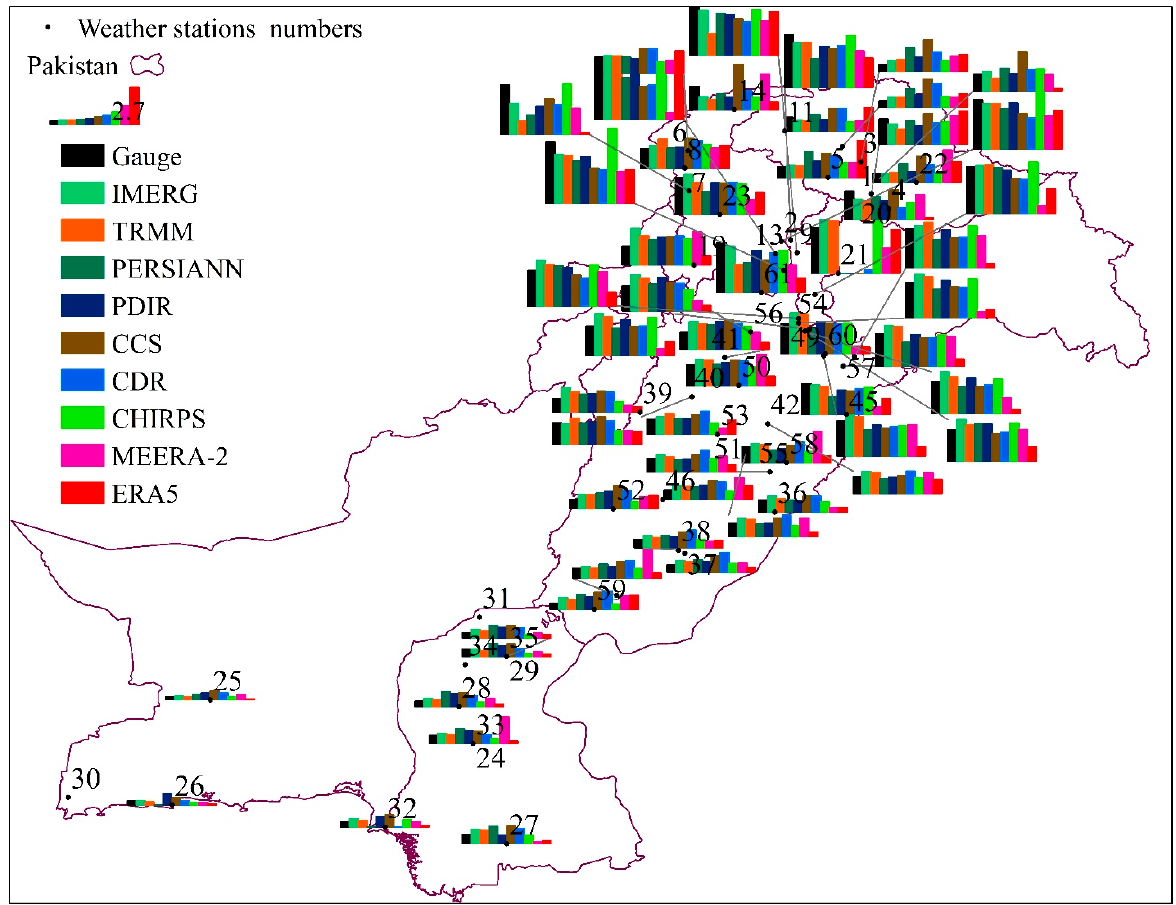
Figure 4. Daily average precipitation spatial variability computed from in situ gauging stations and nine precipitation products (IMERG, TRMM, ERA5, MIRRA-2, PERSIANN-CCS, and PERSIANN-CDR, PERSIANN-PDIR, PERSIANN, and CHIRPS).